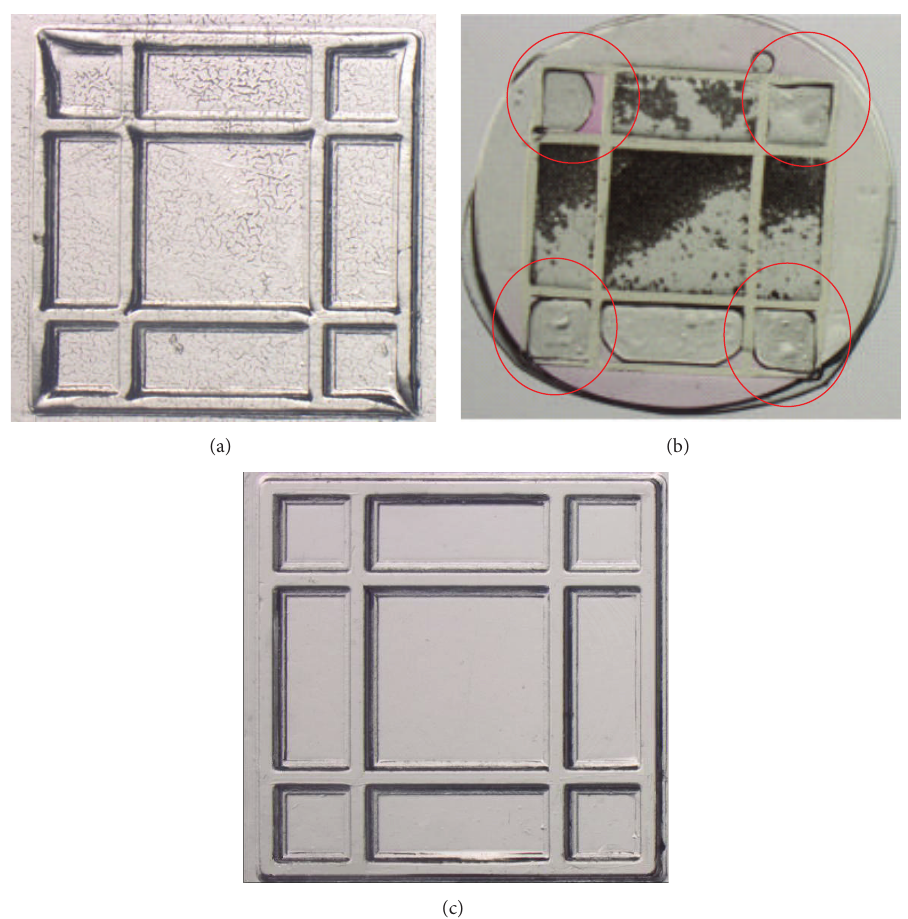
Figure 13: Experimental microstructures under microscope. (a) Short duration of 1min; (b) leaks at the corners; (c) long duration of 3min.